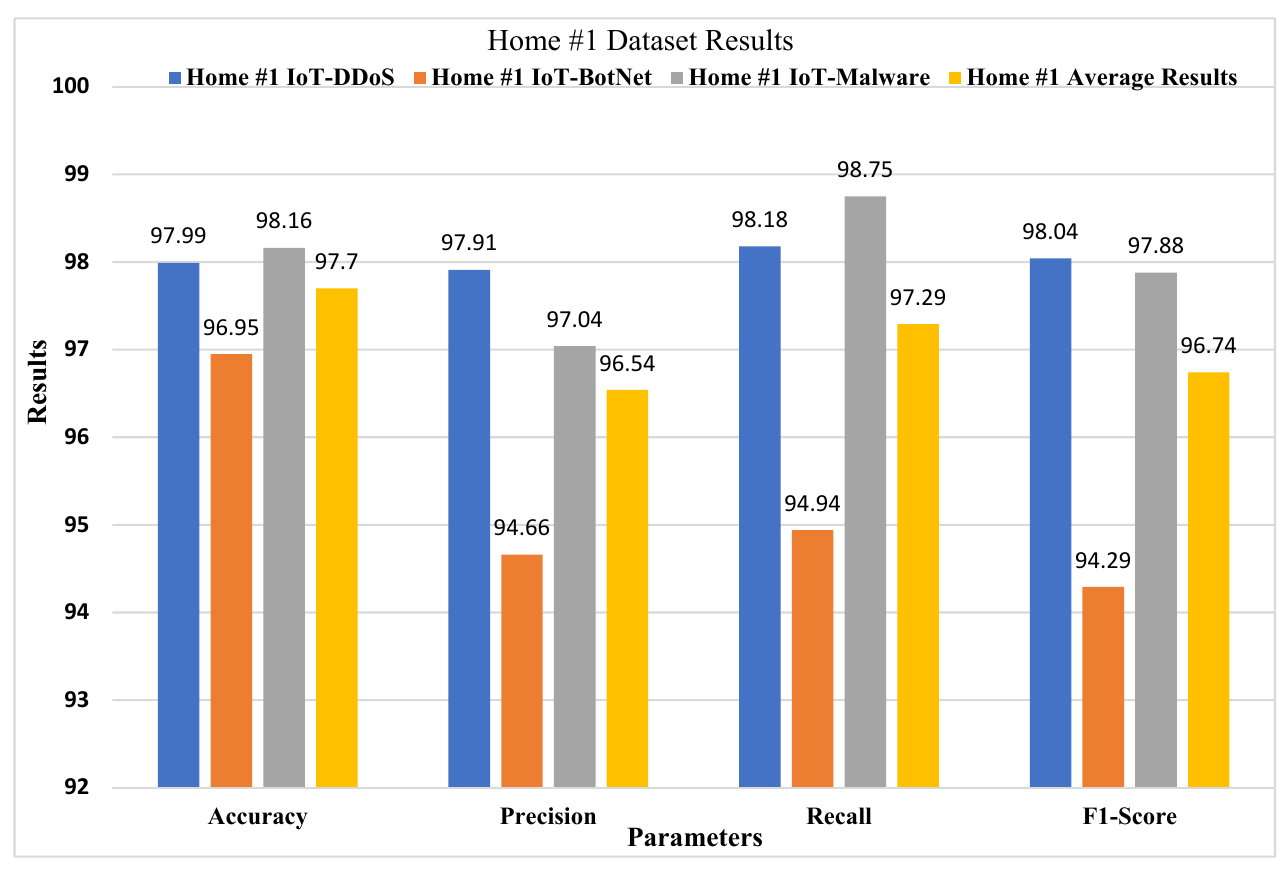
Figure 11. Home #1 dataset results.